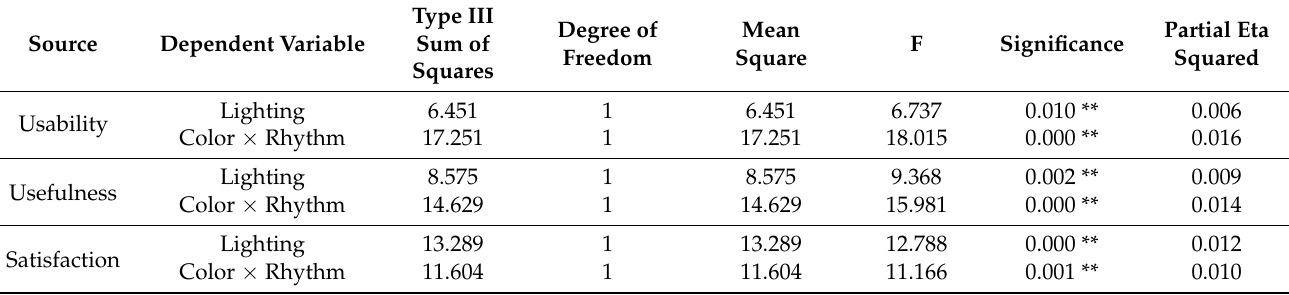
Table 13. Verification and analysis results of effects among subjective cognition combinations in waiting-to-restart